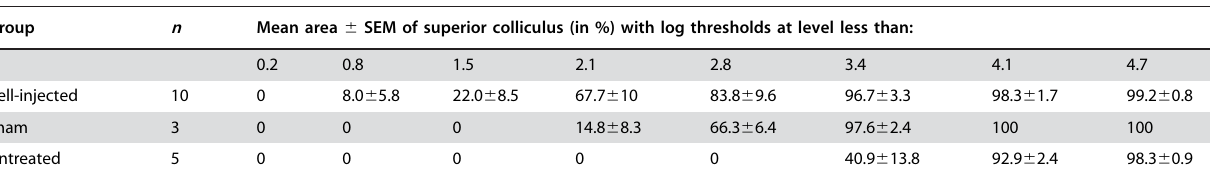
Table 2. Summary of Visual Threshold Measurements from the Superior Colliculus in Different Groups of Animals. .. ... .... ... ... .... ... ... .... ... ... .... ... ... .... ... ... .... ... ... .... ... ... .... ... ... .... ... ... .... ... ... .... ... ... .... ... ... .... ... ... .... ... ... .